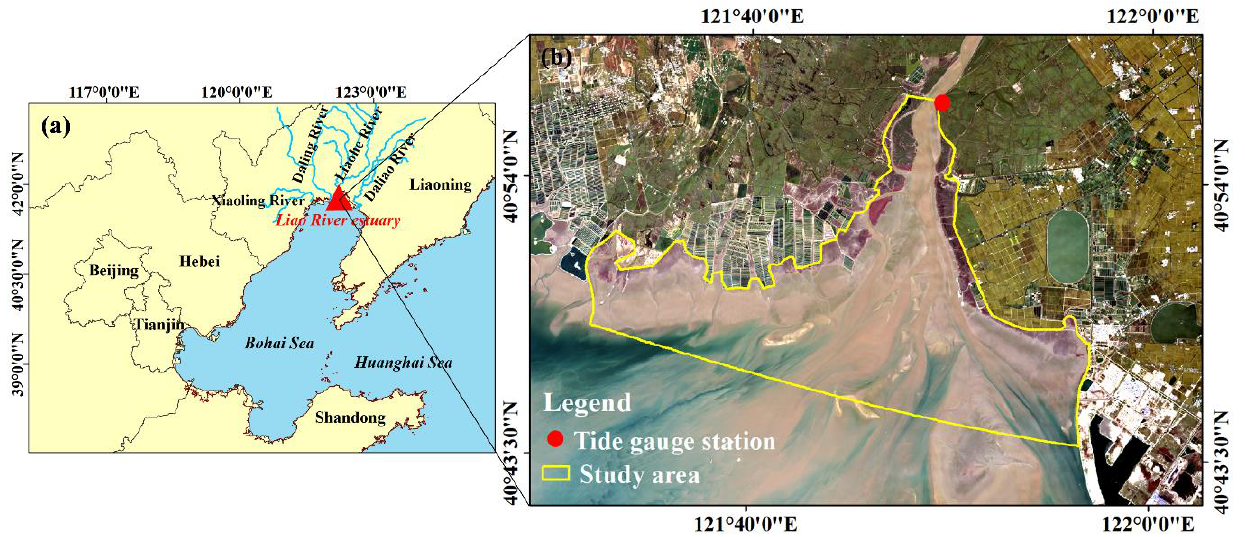
Figure 1. ( a ) The location and ( b ) the study area in the coastal wetlands of the Liao River